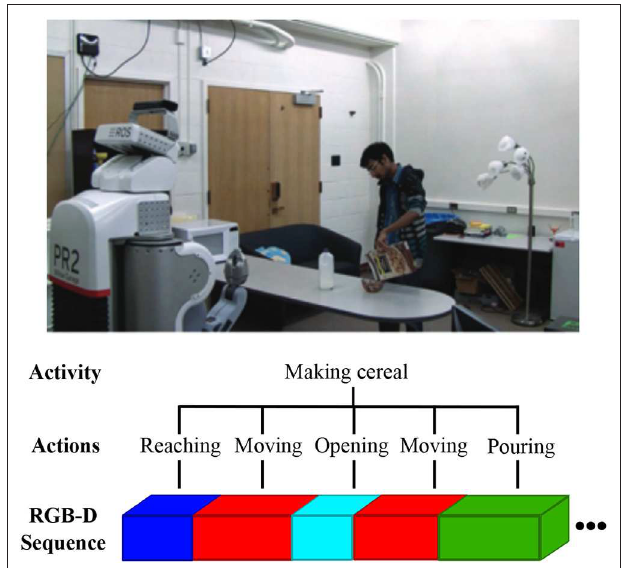
FIGURE 1 | An illustration of the hierarchical compositionality of human activity visually perceived by a robot (the RGB image belongs to the CAD-120 dataset Koppula et al., 2013). The input to the robot is an RGB-D sequence including the spatio-temporal dependencies of the human-object interaction. The sequence represents a high-level human activity which can be semantically segmented into smaller composing actions of varying